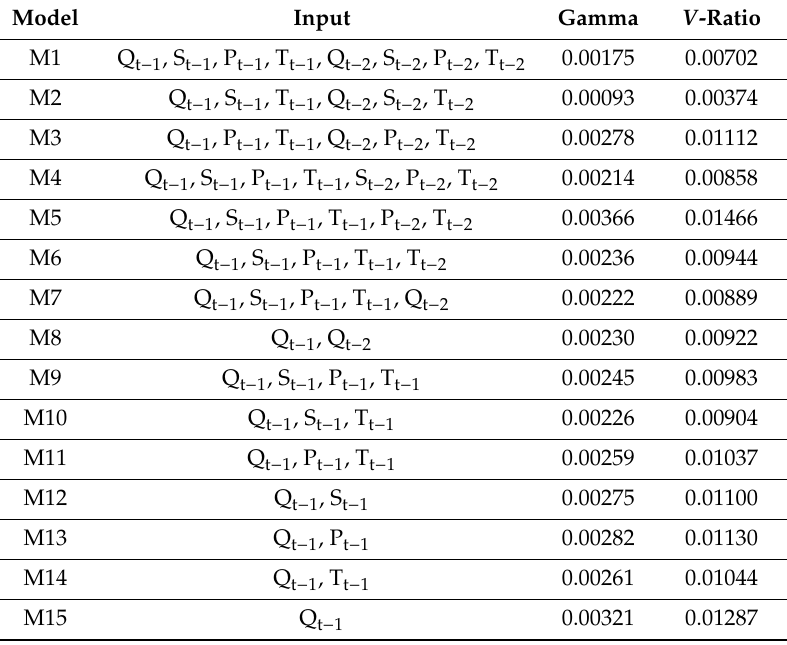
Table 2. Results of the Gamma test for di ff erent input